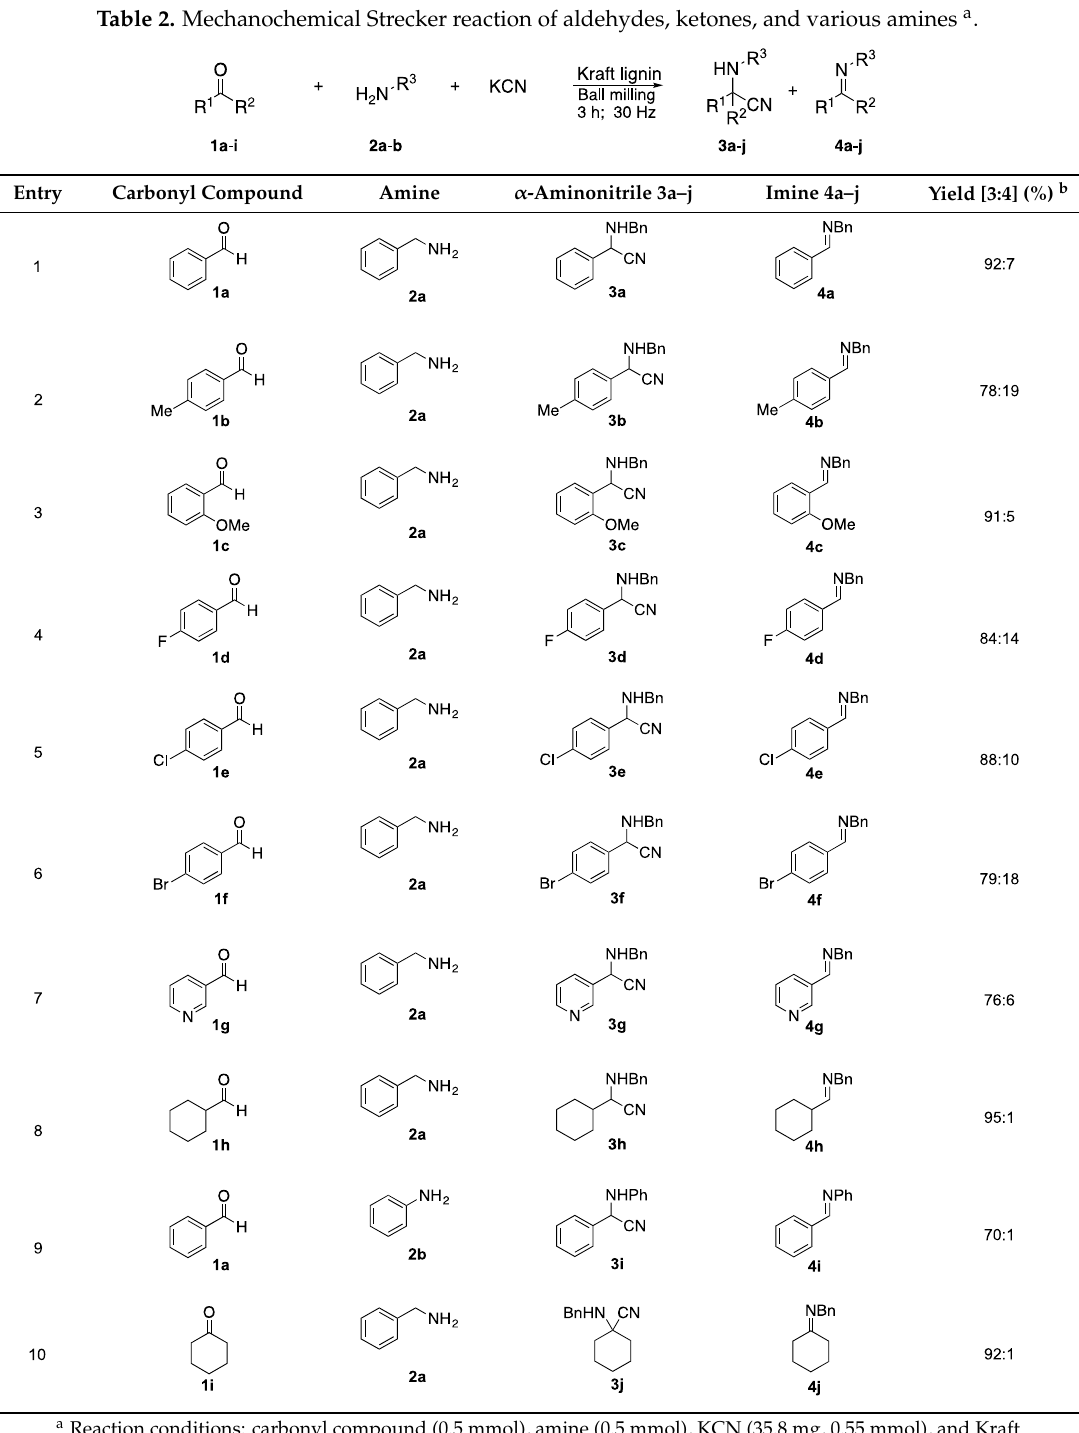
Molecules 2017 , 22 , 146 Table 2. Mechanochemical Strecker reaction of aldehydes, ketones, and various amines a . Table 2. Mechanochemical Strecker reaction of aldehydes, ketones, and various amines a . Table 2. Mechanochemical Strecker reaction of aldehydes, ketones, and various amines a . Table 2. Mechanochemical Strecker reaction of aldehydes, ketones, and various amines a . Table 2. Mechanochemical Strecker reaction of aldehydes, ketones, and various amines a . Table 2. Mechanochemical Strecker reaction of aldehydes, ketones, and various amines a . Table 2. Mechanochemical Strecker reaction of aldehydes, ketones, and various amines a Table 2. Mechanochemical Strecker reaction of aldehydes, ketones, and various amines a .